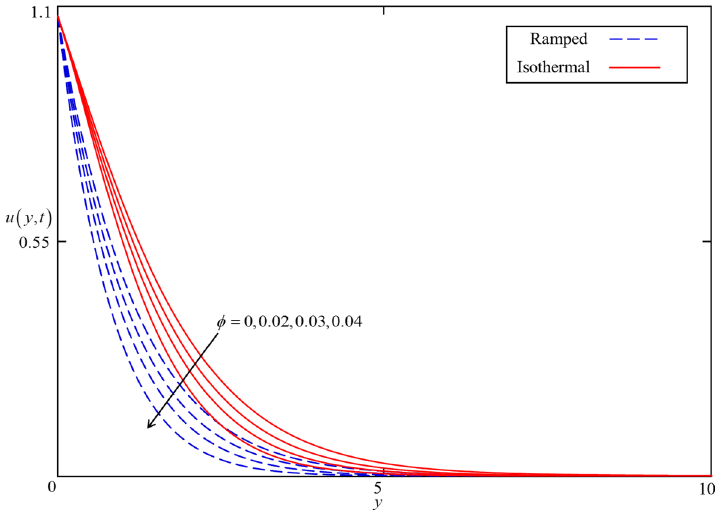
y , t when α = 0.5 , β = 0.5 , M = 0.5 , Gr = 5 , Nr = 0.5 , Q = 0.5 and (cid:31) (cid:30)